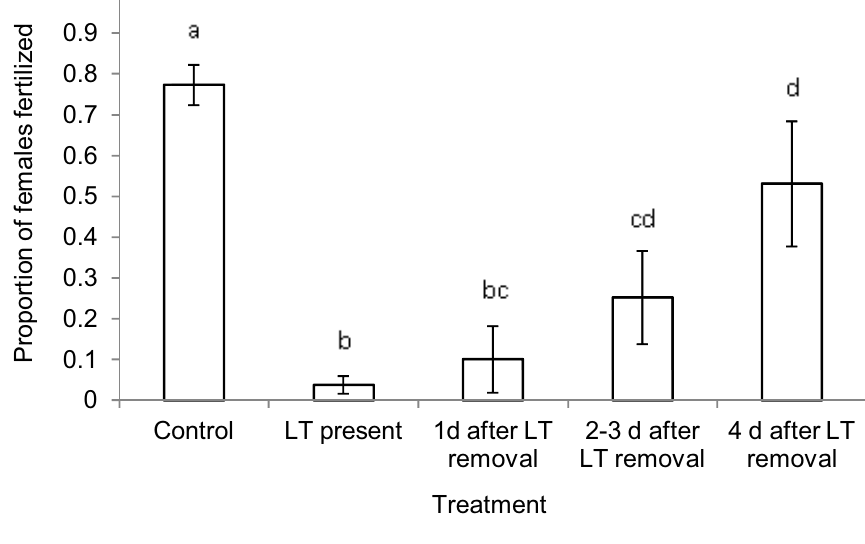
Figure 3. Proportion of females fertilized (± SE) in plots treated with Luretape® GM (LT) in Goshen Wildlife Management Area, VA in 2006. Bars with the same letter are not significantly